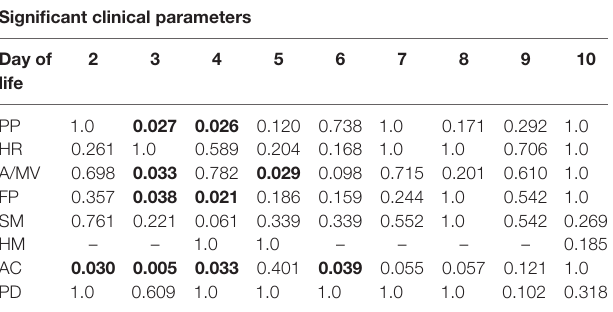
TaBle 2 | Clinical PDA score parameters. significant clinical